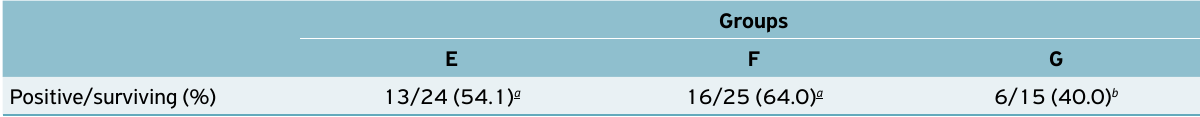
Table 3. Isolation of wild SG 287/91 at 28 dpi in liver and spleen samples of surviving chickens from groups E and F (vaccinated) and group G